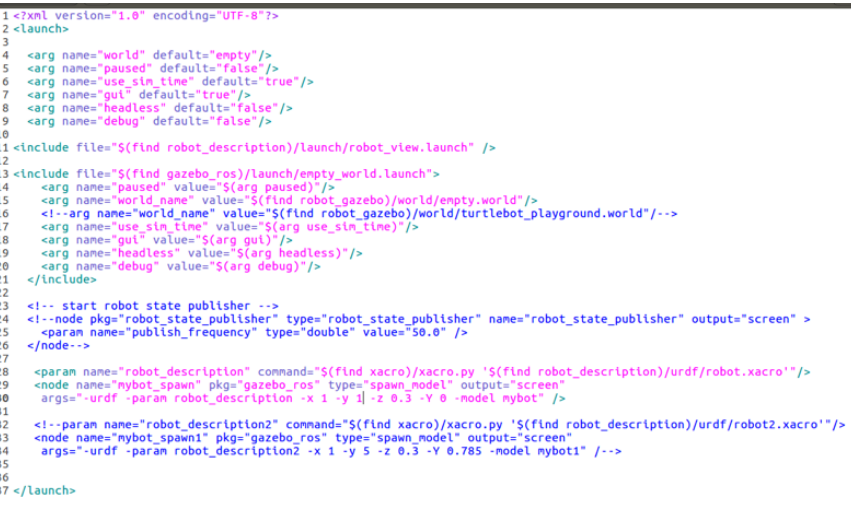
Fig. 8. Launch file for robot’s model in gazebo.